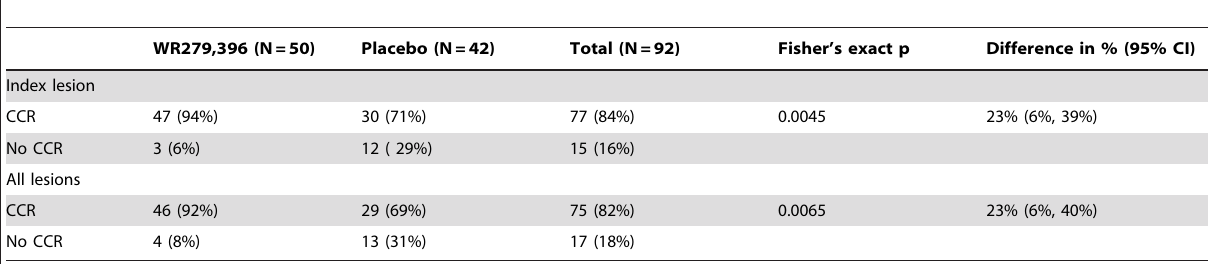
Table 2. CCR at the index lesion and all